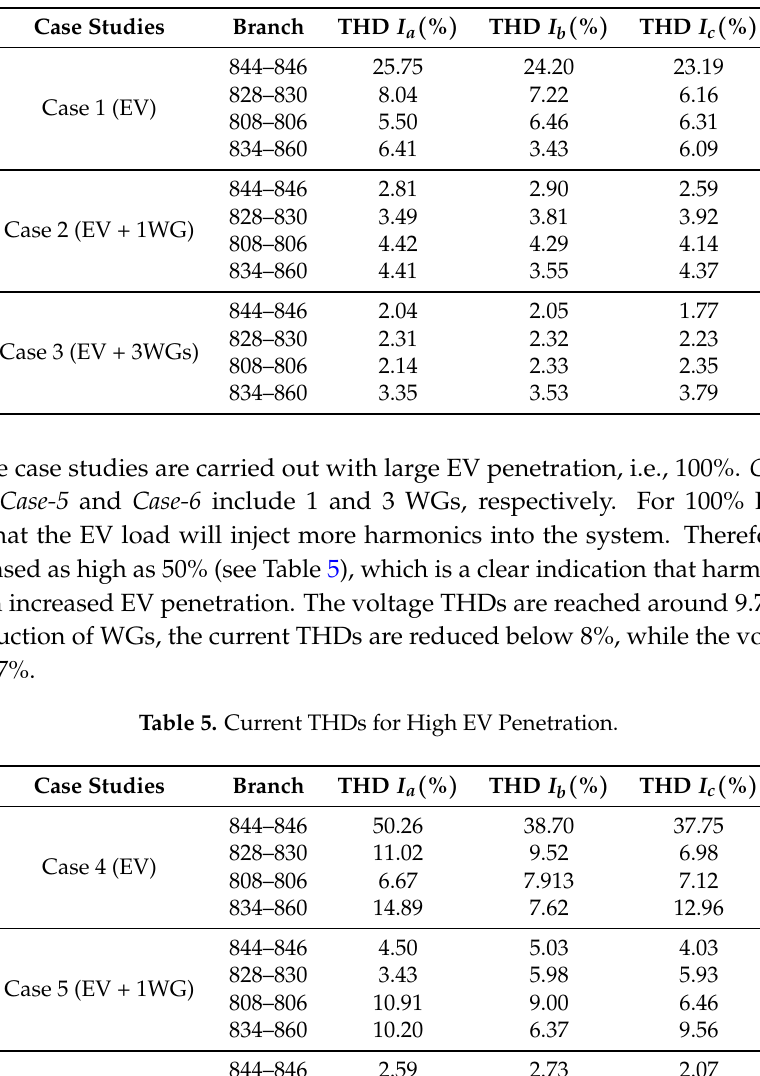
Table 4. Current THDs for Low EV Penetration.